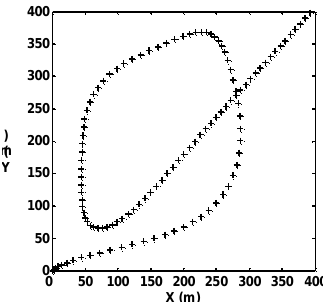
Figure 5. Target trajectory in the sensing field of